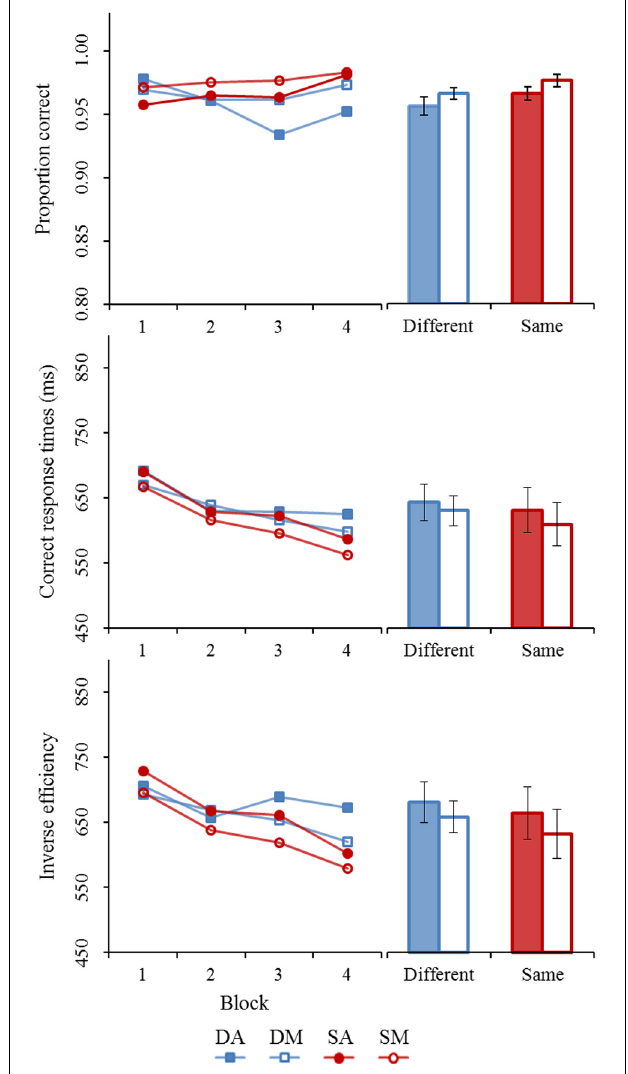
FIGURE 5 | Summary results of Experiment 2 (vertical body composite effect). Each panel shows the averages for each block level (1–4) and for each trial type (different vs. similar). Averages across the blocks are also shown. Error bars represent standard error of the mean. (DA, different aligned; DM, different misaligned; SA, same aligned; SM, different misaligned).